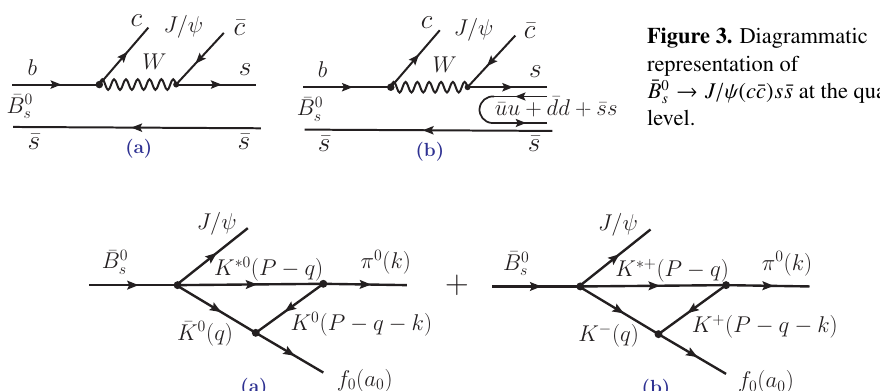
Figure 4. Triangle diagrams for the ¯ B 0 s → J /ψπ 0 f 0 ( a 0 ) decay. The parentheses give the momenta of the − p particles with P = p ¯ B 0 J /ψ . There are two more diagrams corresponding to (a) and (b), substituting s the particles in the triangle loop with their